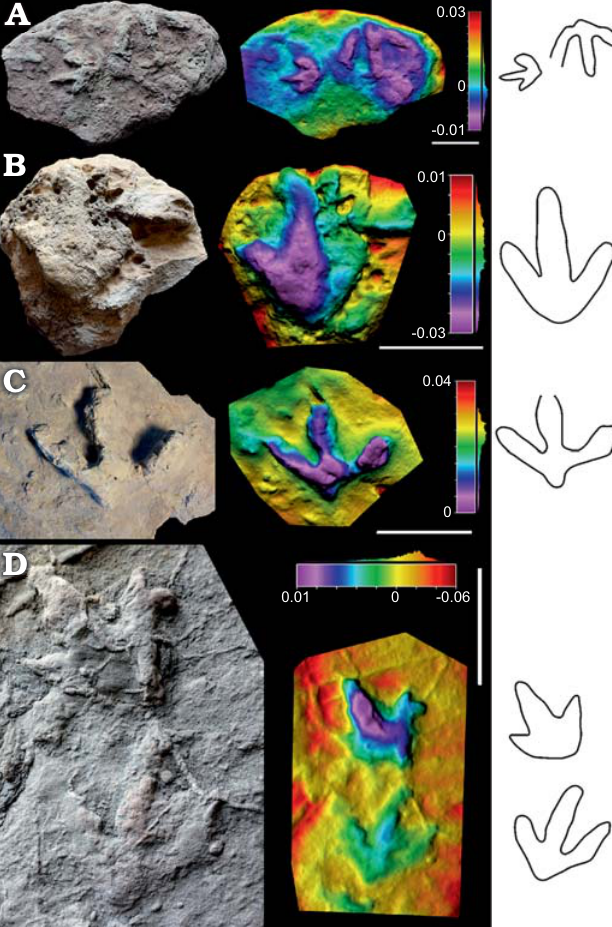
Fig. 5. Photographs, false-colour depth maps and outline drawing of the tracks of high morphological quality (MP = 2) that belong to the Ano- moepus ? isp. morphotype. Portugal, Alcobaça Formation, Kimmeridgian– lower Tithonian (A–C) and Praia de Amoreira-Porto Novo Formation, upper Kimmeridgian (D). A . SHN.(JJS).ICNO.34A (left) considered Ano- moepus? isp. and SHN.(JJS).ICNO.34B, (right) considered Ornitho poda indet., Boavista do Bouro. B . SHN.(JJS).ICNO.37, Boavista do Bouro. C . SHN.(JJS).ICNO.105C, Serra do Bouro. D . SHN.(JJS).ICNO.18A (top) and SHN.(JJS).ICNO.18B (bottom), Praia da Corva. Scale bars 10